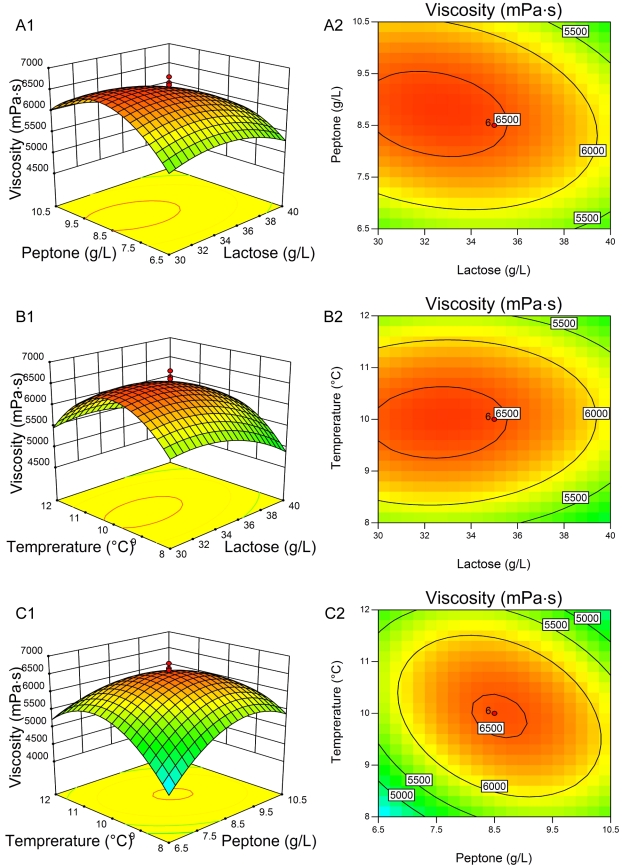
Three-dimensional plots and corresponding contour plots of the effect of three variables on broth viscosity.When the effect of two variables was plotted, the other variable was set at central levels. A, interaction of lactose and peptone; B, interaction of lactose and temperature; C, interaction of peptone and temperature.